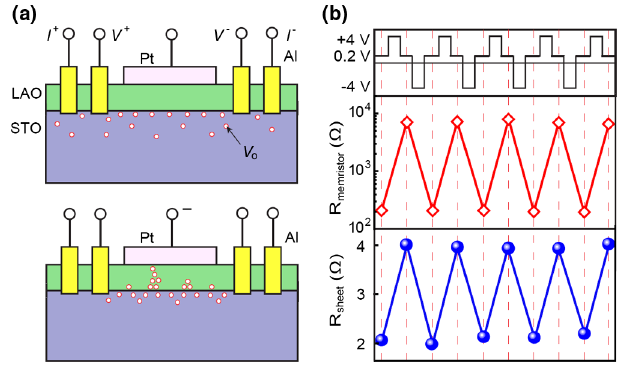
FIG. 7. (a) Schematic diagram of the experimental setup for monitoring the sheet resistance of electron gas after switching the memristor into different resistance states. As depicted in the figure, the four-point configuration with bonded Al electrodes is used to record the lateral sheet resistance. When a negative voltage bias is applied to the top Pt electrode, oxygen vacancies are driven toward the interface, which should not only render the LRS but also decrease the sheet resistance of the electron gas in STO. The reverse effect occurs when a positive bias is applied. (b) ‘‘In-plane’’ sheet resistance of the electron gas changes accordingly when voltage pulses of (cid:5) 4 V are applied to the top Pt electrodes that concurrently switch the ‘‘out-of-plane’’ memristor into the HRS and LRS. For the CIP transport, the readout voltage is 0.2